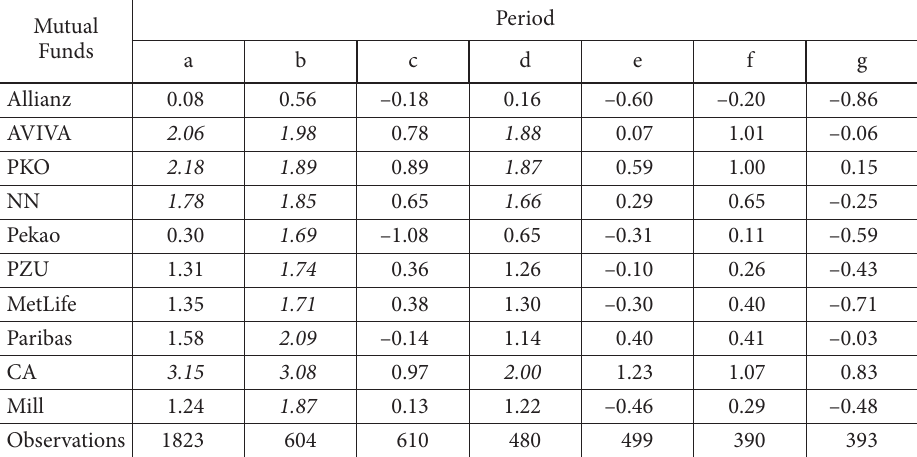
Table 3. Values of statistic (1) verifying that daily returns from mutual funds in considered periods equal zero (source: own